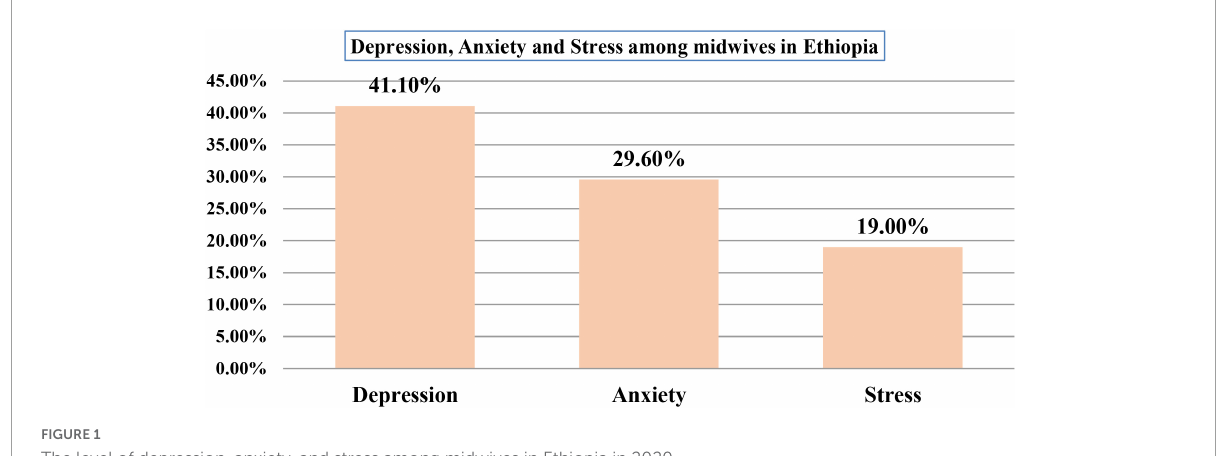
FIGURE1 The level of depression, anxiety, and stress among midwives in Ethiopia in 2020.